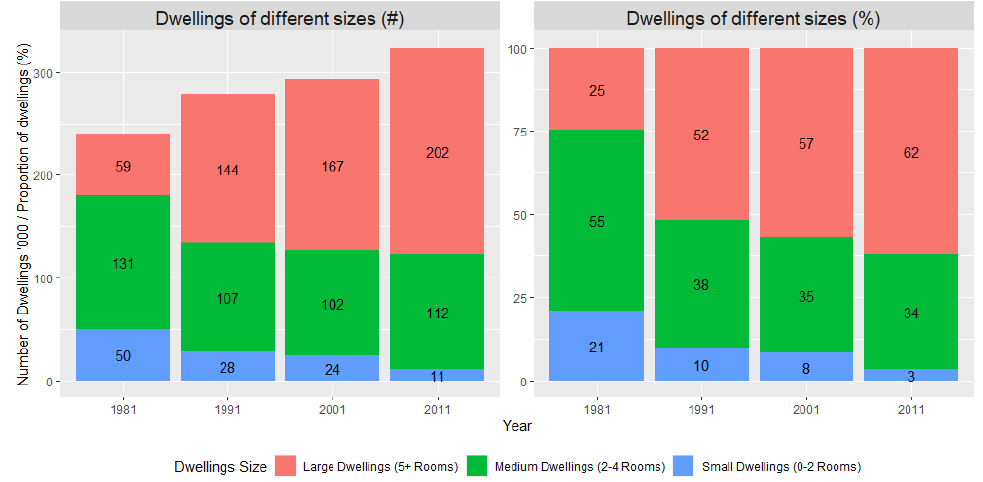
Figure 4. Family dwellings size in Lisbon, 1981–2011. Source: Own elaboration, with data from Census records 1981–2011.